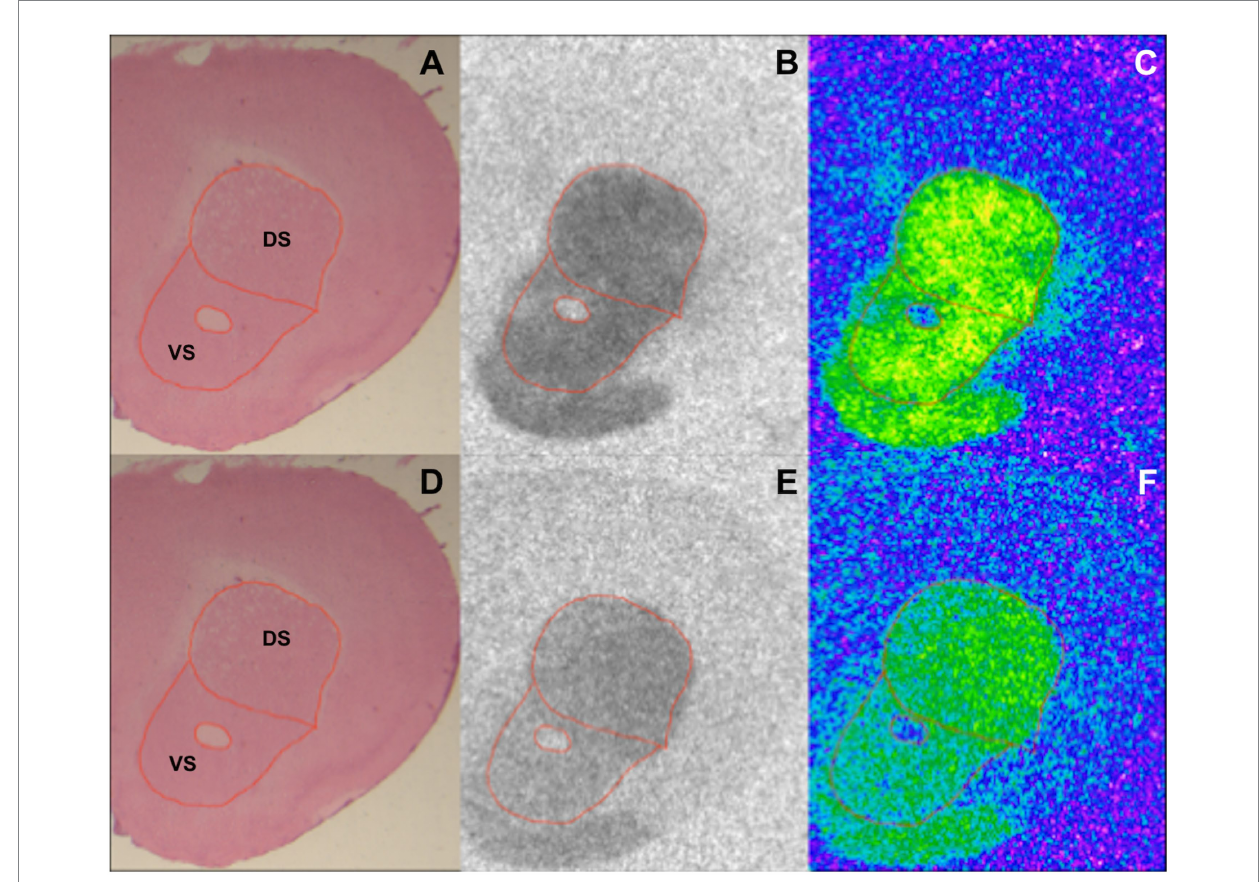
FIGURE 1 Exemplary section from a BTBR 12-week-old mouse showing DS and VS in an HE stained section (A,D) , autoradiographic image of binding to D1 (B) and D2 receptors (E) , and the corresponding color-coded picture of the same autoradiogram [ (C,F)